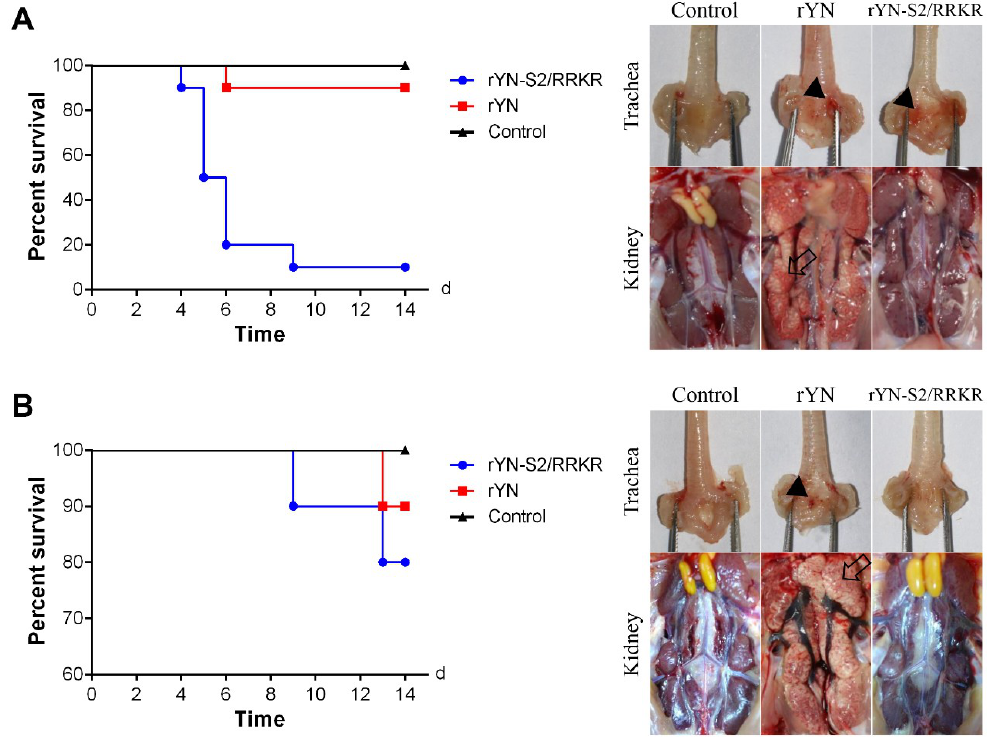
Figure 2. Furin-S2′ site can cause high mortality in SPF chicken without obvious gross kidney injury. ( A ) Survival rate of 1-day-old SPF chickens inoculated with rYN or rYN-S2/RRKR. rYN-S2/RRKR was highly pathogenic to 1-day-old SPF chickens, with a mortality rate of 90% (9/10), while the mortality rate of rYN was 10% during the observation period (left). Results of necropsy at 9 dpi on 1-day-old chickens inoculated with rYN or rYN-S2/RRKR. Mucus and punctate hemorrhage in the larynx and trachea (black triangles), substantial urate deposits in the ureter and kidney swelling were observed (blank arrow), while only mucus and punctate hemorrhage in the larynx were observed in the rYN-S2/RRKR group (right). ( B ) Survival rate of 3-week-old SPF chickens inoculated with rYN or rYN-S2/RRKR. Diseased chickens in the rYN-S2/RRKR group appeared later than in 1-day-old chickens and the mortality rate was 20% (2/10). The mortality of rYN was still 10%, but disease onset was delayed (left). At necropsy of diseased chickens at 13 dpi, mucus and punctate hemorrhage in the larynx (black triangles) and mottled swelling kidney (blank arrow) were observed in the rYN-inoculated group. There were no obvious gross lesions in the rYN-S2/RRKR group and negative control group (right).